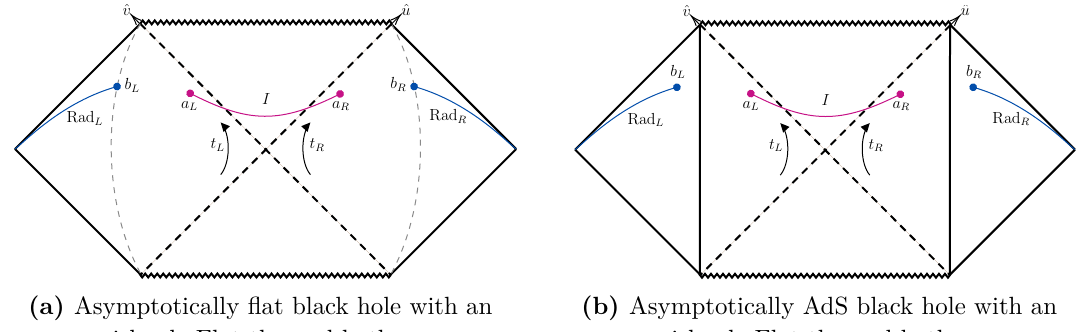
Figure 2. Penrose diagrams with islands ( Left : asymptotically flat black hole with single horizon and singularity. right : asymptotically AdS black hole with single horizon and singularity). The pink lines are islands whose boundaries are outside the horizon. The dotted gray lines in (a) are boundaries of collecting region for the Hawking radiation. The blue lines stand for collecting region with boundaries b in a Schwarzschild time slice. We consider the symmetric case that L ( R ) = t = t , t = t = t , r = r = r , r ∗ = r ∗ = r ∗ t b b R b a L a R a a L a R a b L b R b L